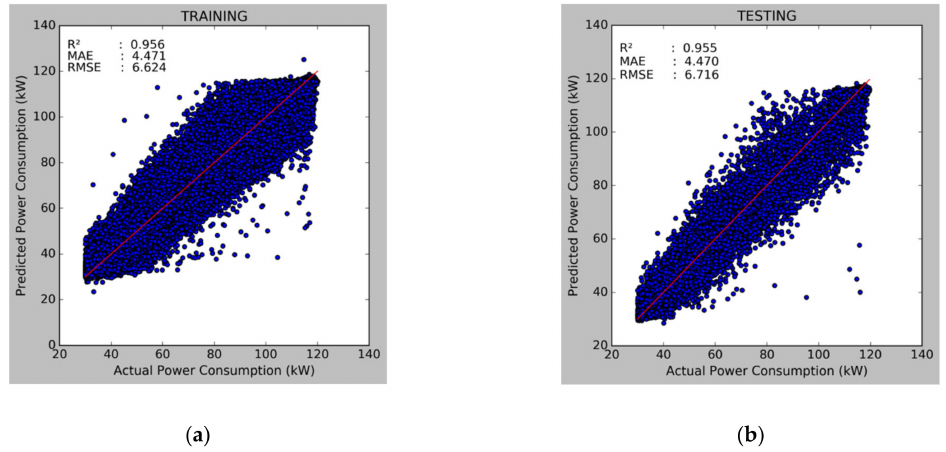
Figure 6. The scatter plots between the actual and predicted power consumption and the model assessment: ( a ) training, ( b )